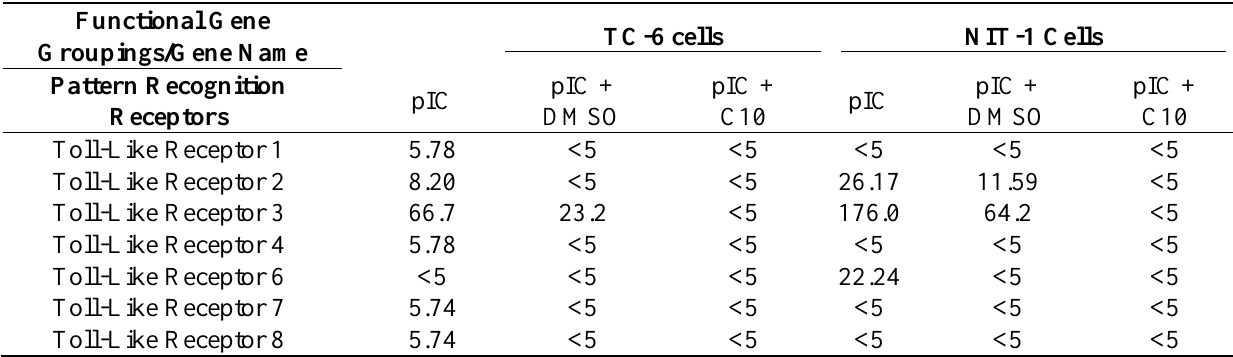
Table 1. Relative fold changes induced by pIC and inhibition by C10 on TLR signaling array. Functional Gene